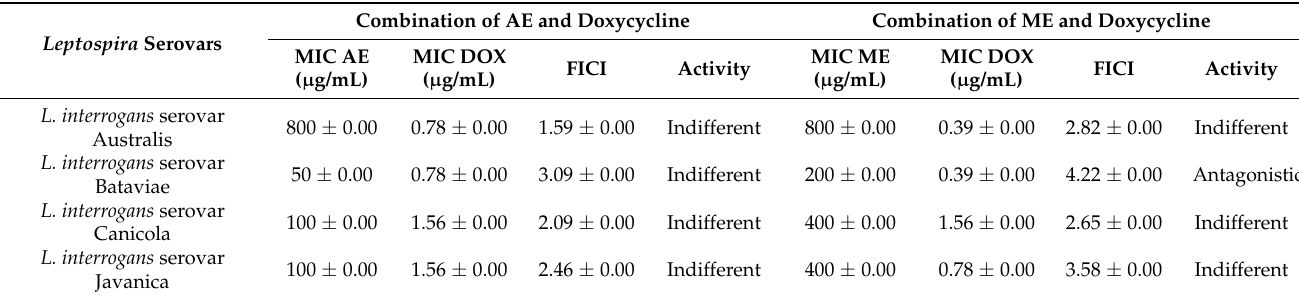
Table 3. FICI values of AE and ME in combination with doxycycline against Leptospira serovars by checkerboard assays and the activities. The test was duplicated and reported in mean ± SD.